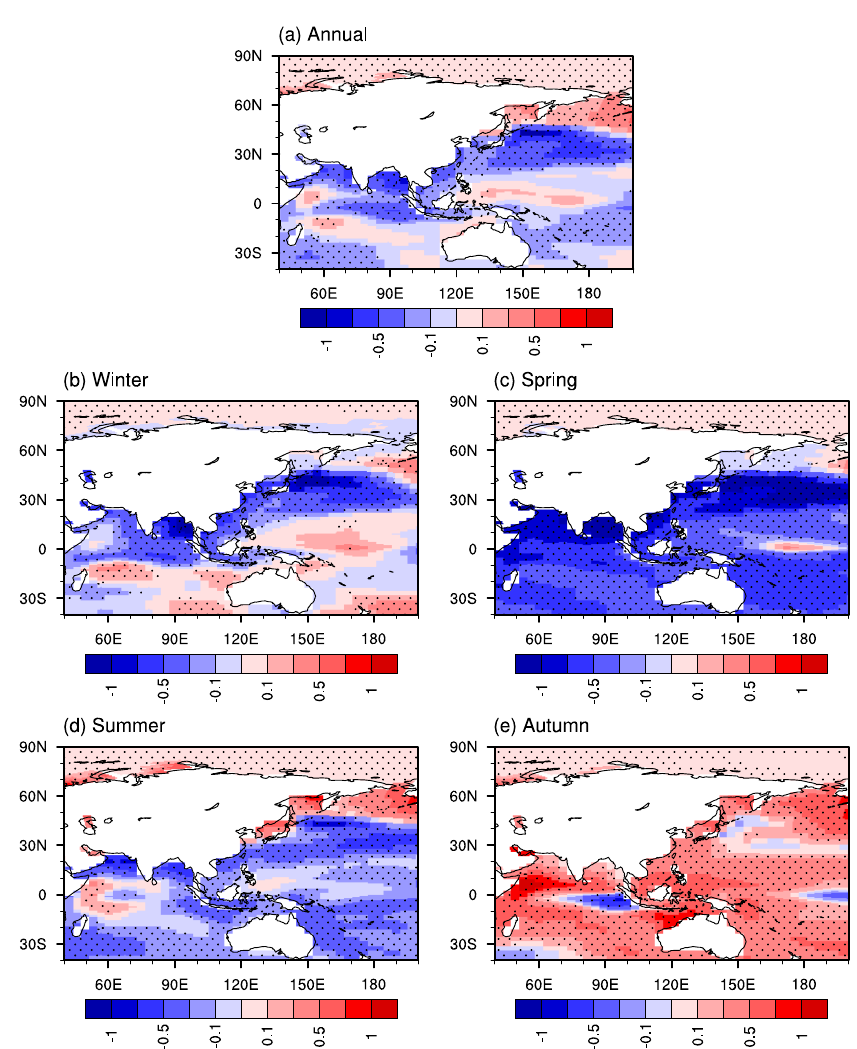
Fig. 4. Simulated differences in annual and seasonal sea surface temperatures (units: K) between AO(6ka) and AO(0ka) experiments. The areas exceeding 90% confidence level are